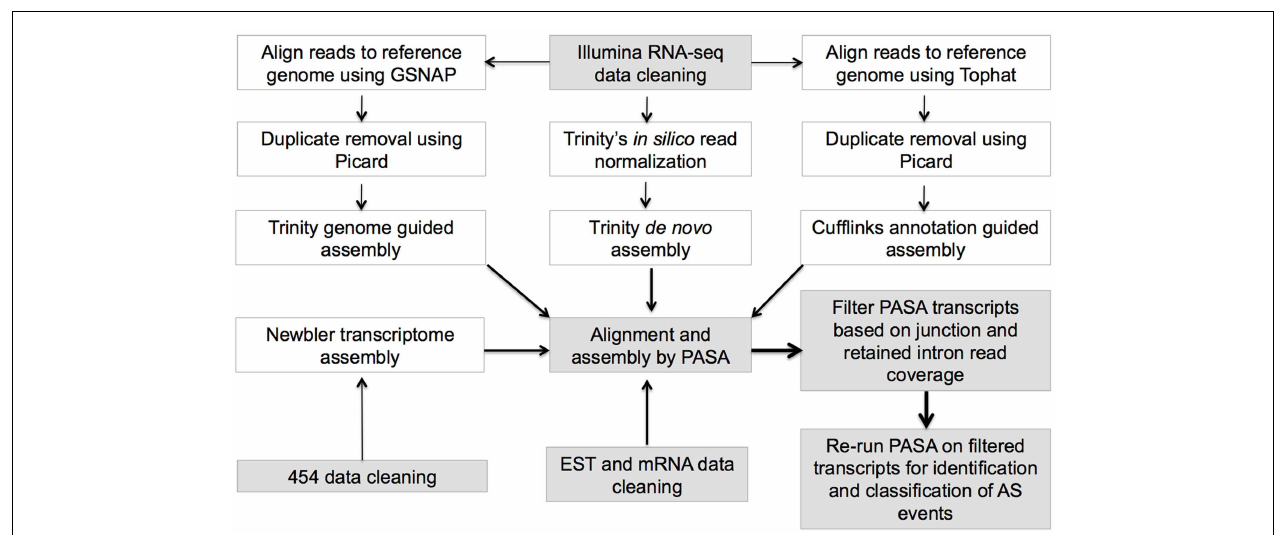
FIGURE 1 |Workflow of transcriptome data pre-processing and PASA assembly .